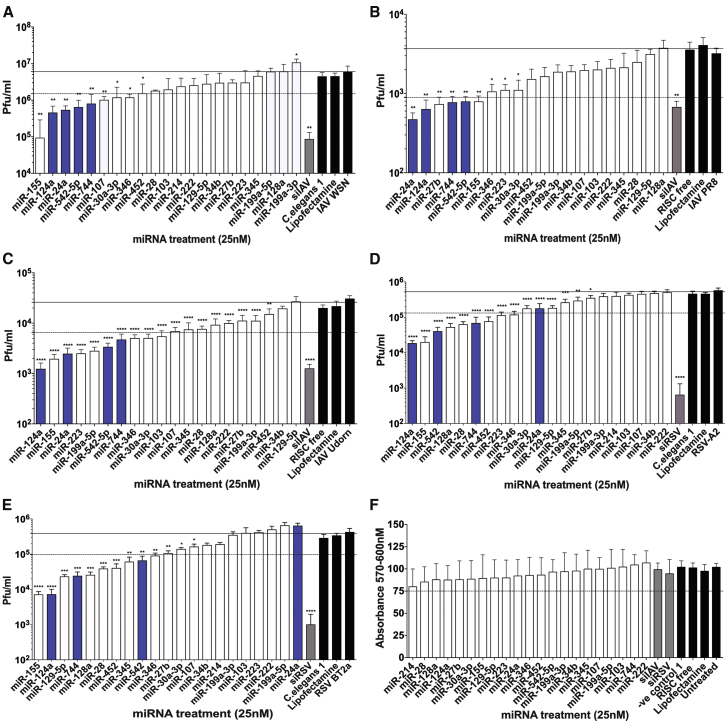
Reductions in IAV and RSV Titer following Treatments with miRNA MimicsA549 cells were transfected with 25 nM miRNA mimics or controls. A direct-targeting viral siRNA (siIAV or siRSV) served as a positive antiviral control (gray bar), while negative controls were as follows: C. elegans miRNA mimic 1 (C.elegans 1), RISC-free siRNA, Lipofectamine, and virus infection alone (black bars). (A–E) After 48-hr transfection, media was removed and cells were infected with (A) IAV WSN H1N1 at MOI 0.1 for 24 hr, (B) IAV PR8 H1N1 at MOI 0.1 for 12 hr, (C) IAV Udorn H3N2 at MOI 0.1 for 24 hr, (D) RSV-A2 at MOI 0.01 for 72 hr, and (E) RSV-BT2a at MOI 0.1 for 72 hr, when the supernatant was removed and assayed for virus. (F) Uninfected cells were analyzed for cell viability at 48 hr post-transfection (n = 12). The results are displayed to show the most potent antiviral mimics (from left to right along the x axis), with solid lines denoting 0% inhibition, dotted lines denoting the 75% activity cutoff, and blue bars highlighting miRNAs chosen for further analysis. Viral titer results for each virus are shown as the mean ± SEM of n = 6. Significant differences between virus control and miRNA mimics and siRNAs are indicated (*p < 0.05, **p < 0.01, ***p < 0.001, and ****p < 0.0001, one-way ANOVA).